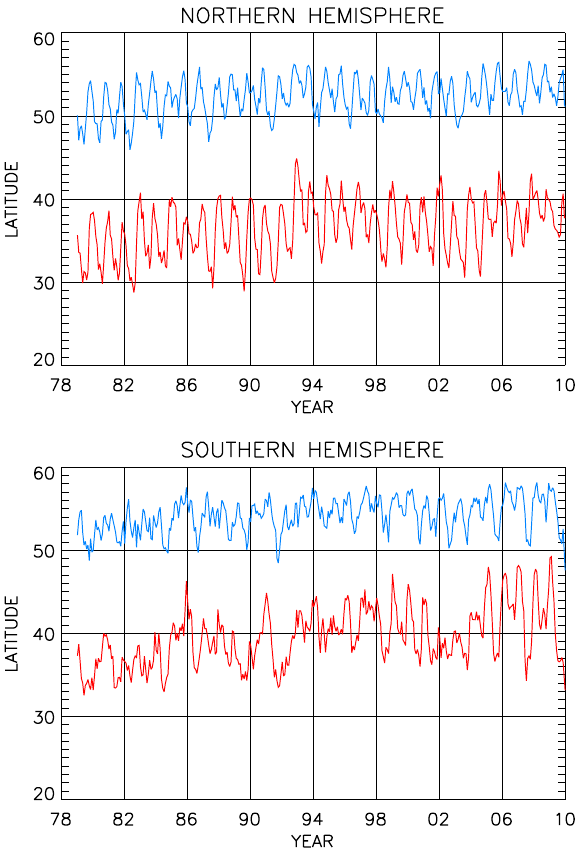
Fig. 4. Monthly mean equivalent latitude of the subtropical and Po- lar fronts for the Northern Hemisphere (upper panel) and the South- ern Hemisphere (lower panel) for the region between the equator and 60 ◦ latitude.